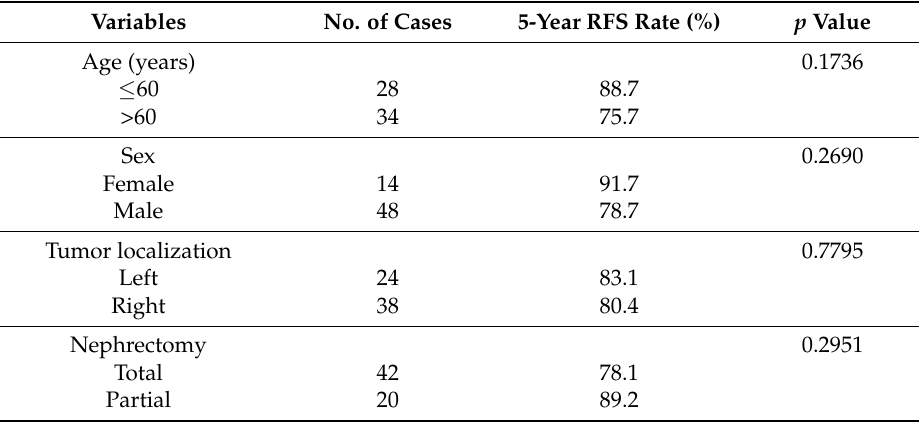
Figure 2. Kaplan–Meier curve for the 5-year RFS ( a ) and CSS ( b ) of a total of 62 patients included in this study. Table 3. Univariate analysis of factors predicting recurrence after